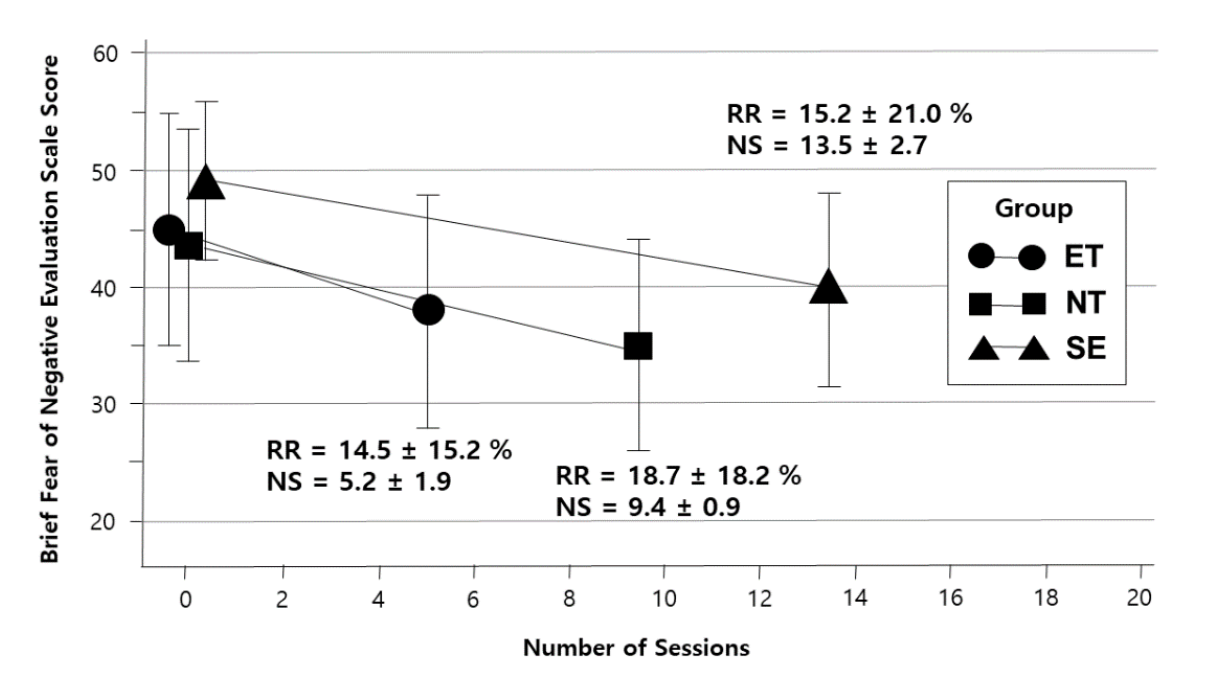
Figure 2. Group-specific changes in the Brief Fear of Negative Evaluation Scale scores for each participant from baseline to the last session. The number of sessions (NS) varied depending on the participants from one to eight in the early termination group (ET), nine to ten in the normal termination group (NT), and 11 to 20 in the session extension group (SE). Reduction rate (RR) = [(score at baseline − score in the last session)/score at baseline] × 100%.